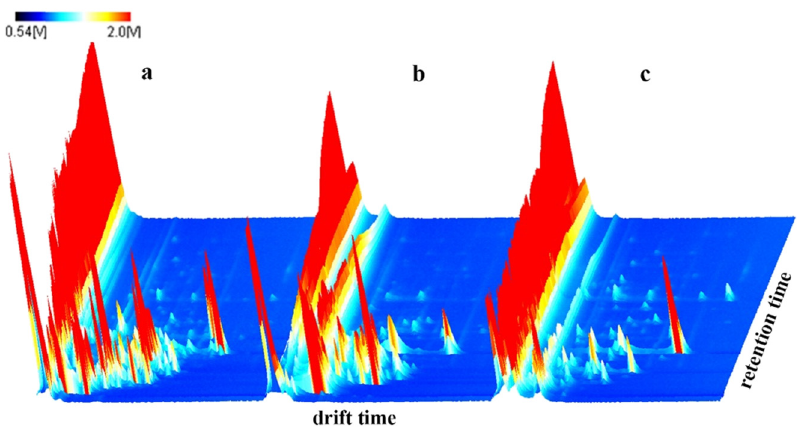
Figure 1: 3D topographical visualization view of di ff erent extraction methods: ( a ) squeezing extracted; ( b ) supercritical carbon dioxide extracted; ( c ) aqueous extracted.